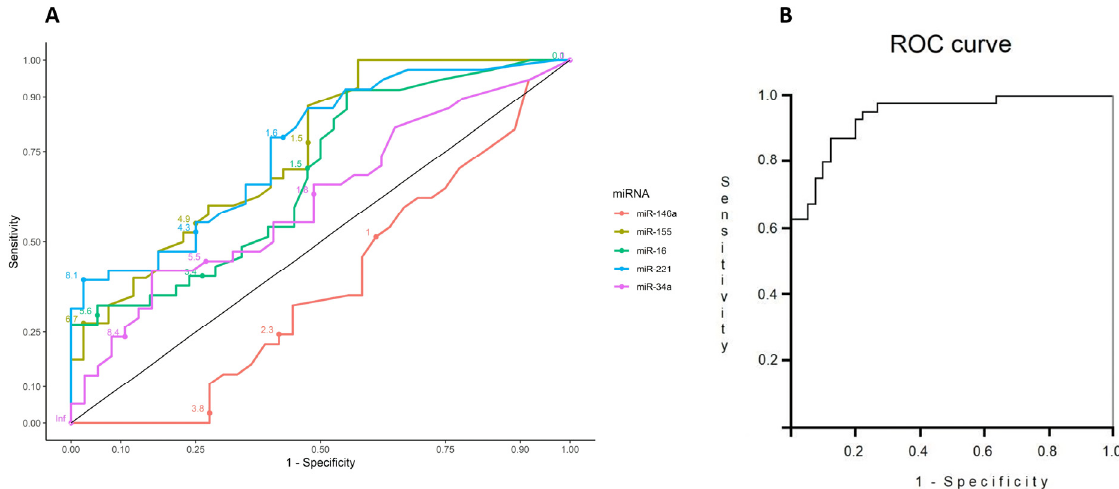
Figure 3. ( A ) ROC curve with individual miRNAs. ( B ) ROC curve built with the variables included in the logistic regression model. (AUC: 0.95, 95%CI 0.89–0.98). Nagelkerke pseudo-R 2 statistic, ranging from 0 to 1.